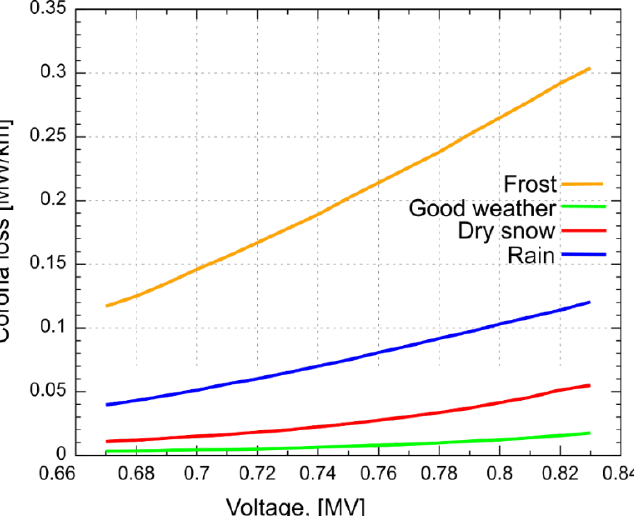
Figure 7. Dependences of the specific losses of active power per corona on the voltage at the 750 kV power transmission line Vinnitsa-Zapadno-Ukrainskaya for typical weather conditions (National Power Company “Ukrenergo”). Table 2. Results of approximation and obtained coefficient of